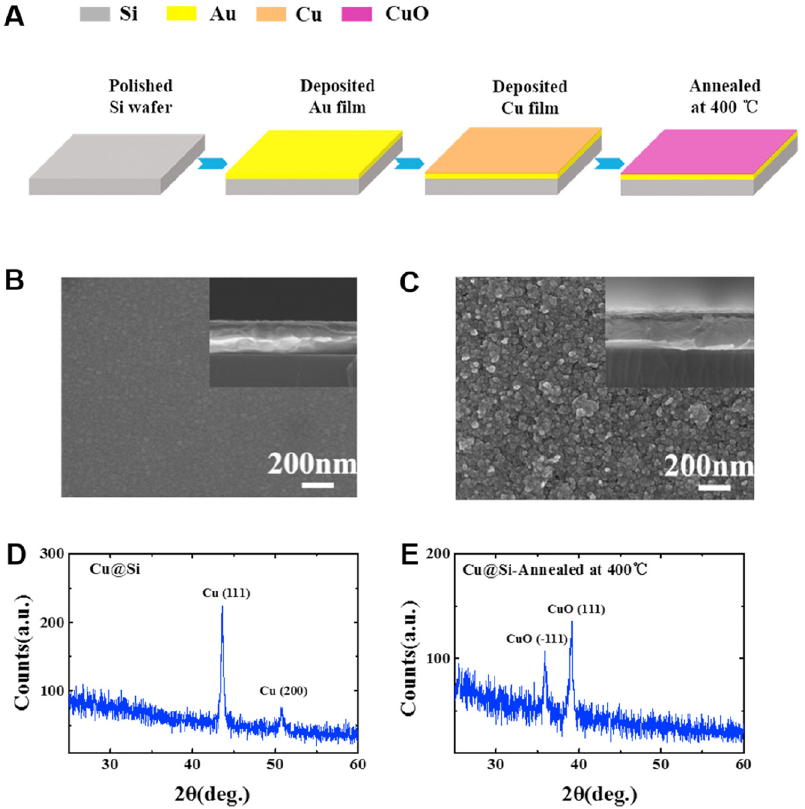
Figure 1: Fabrication process and characterization of the proposed bilayer thin-film nanostructures. (A) Schematic of the fabrication process of the proposed CuO/Au bilayer nanostructure. Surface and cross-sectional (insert) SEM images of a fabricated sample (B) before annealed (with 14 nm of Cu thin fi lm) and (C) after annealed(with30nmofCuOthin fi lm).XRD patternsofastructureconsistingofa50nm thick Cu fi lm deposited on Si substrate, before annealed (D) and after annealed